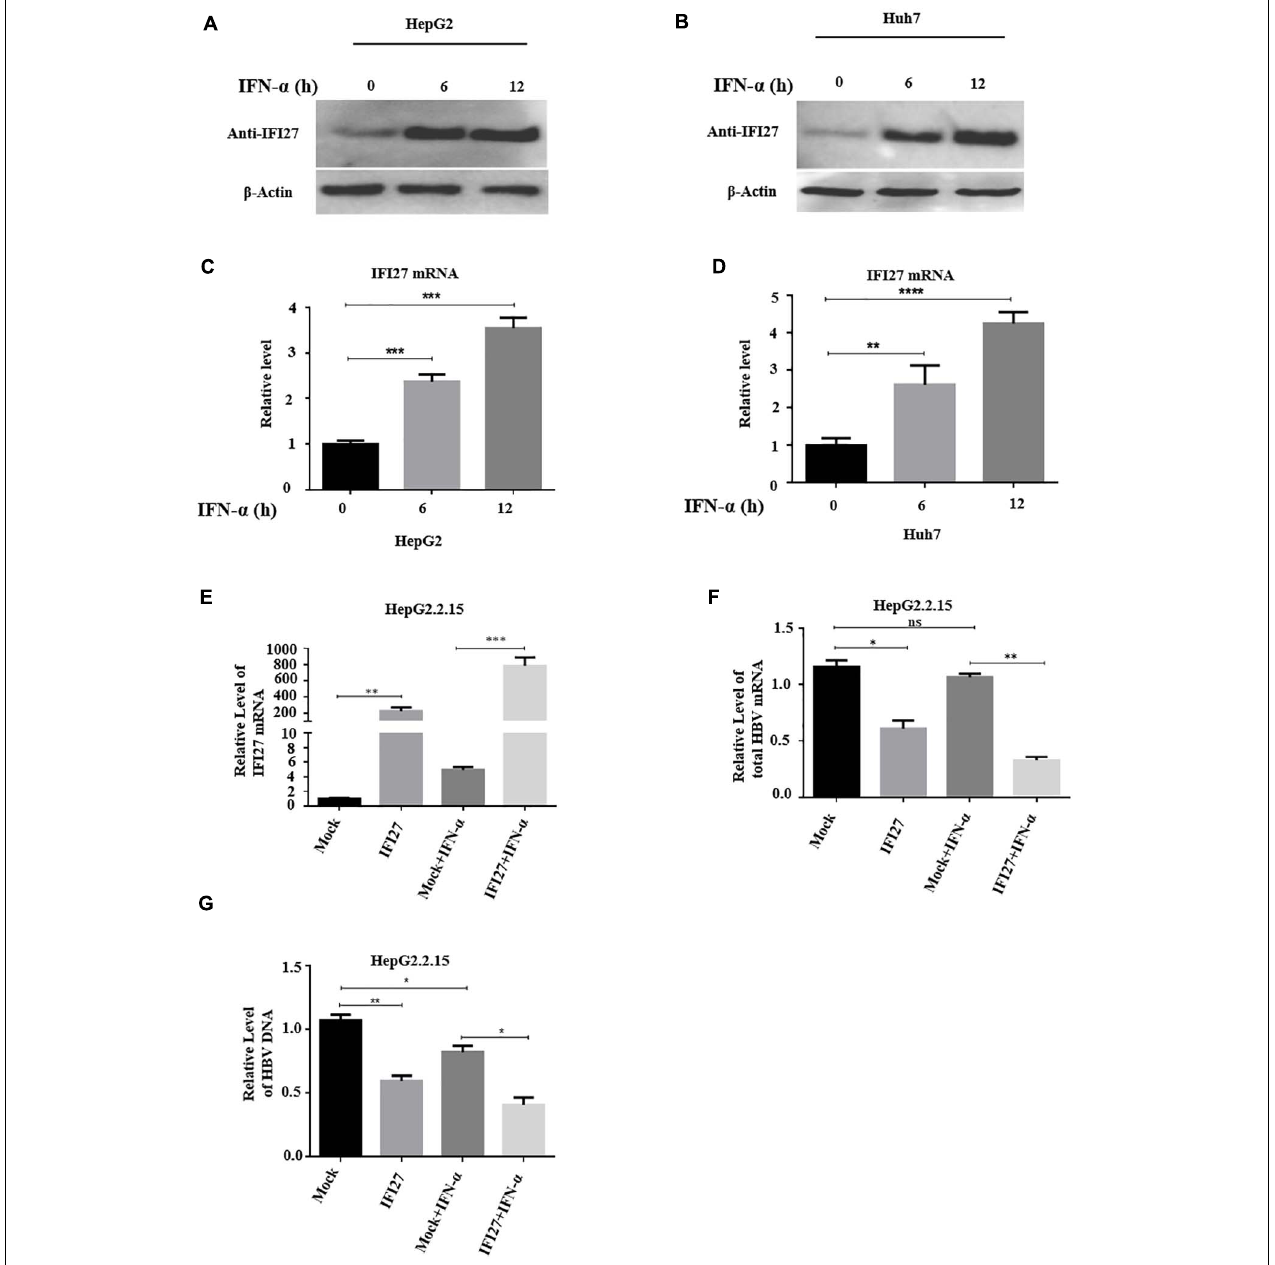
FIGURE 1 | Interferon alpha (IFN- α ) induces interferon alpha-inducible protein 27 (IFI27) expression and the role of IFI27 in IFN-elicited anti-hepatitis B virus (HBV) response in human hepatoma cells. (A–D) HepG2 and Huh7 cells were treated with IFN- α (100 ng/ml) and incubated for 0, 6, and 12 h. (A,B) The treated HepG2 and Huh7 cells were subjected to western blotting or immunoblotting using an anti-IFI27 antibody, where β -actin was taken as a normal internal reference control (bottom panels). (C,D) The total HBV RNA was isolated from the treated cells, and the expression of IFI27 of mRNA was determined by using qRT-PCR. Glyceraldehyde-3-phosphate dehydrogenase (GAPDH) mRNA expression was used as a loading control to normalized the data. (E–G) pCAGGS-HA-IFI27 or pCAGGS (empty vector) plasmid was transfected into HepG2.2.15. After 24 h of incubation, the cells were treated with IFN- α (100 ng/ml). (E,F) The relative expression level of IFI27 mRNA and total HBV mRNA was examined by qRT-PCR. GAPDH was used as an internal control. (G) HBV intracellular DNA expression level was determined by qPCR. * P ≤ 0.05, ** P ≤ 0.01, *** P ≤ 0.001, **** P ≤